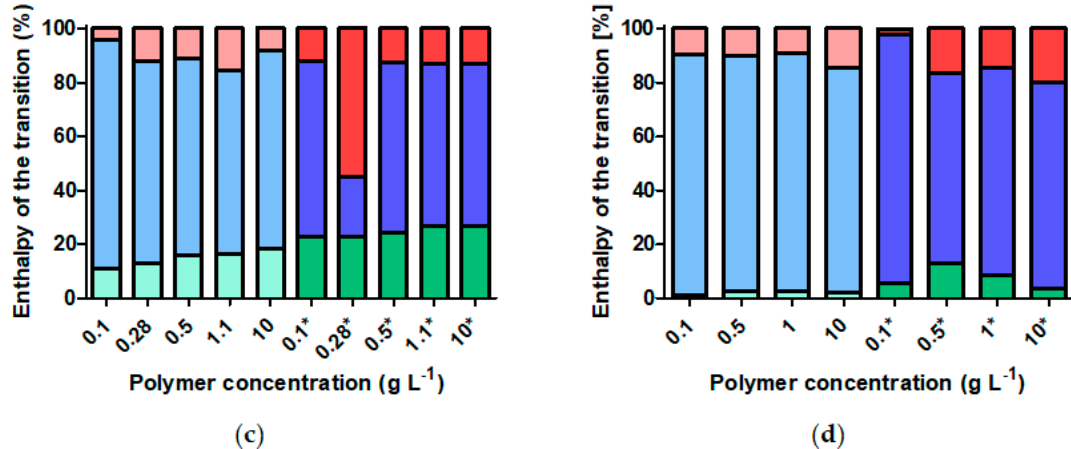
Figure 8. Fraction of the total transition enthalpy of each fitted transition peak for core-shell nanoparticles. All DSC curves were fitted with three Gaussian curves. The enthalpy of each fitted Gaussian was normalized by the total enthalpy of the transition to obtain the plotted fractions. Contributions of the lowest (red), intermediate (blue) and highest (green) temperature transitions were assigned to the inner, intermediate and outer shell, respectively. The cooling curves are marked with *. ( a ) FeOx-5; ( b ) FeOx-7; ( c ) FeOx-10; ( d ) FeOx-21.